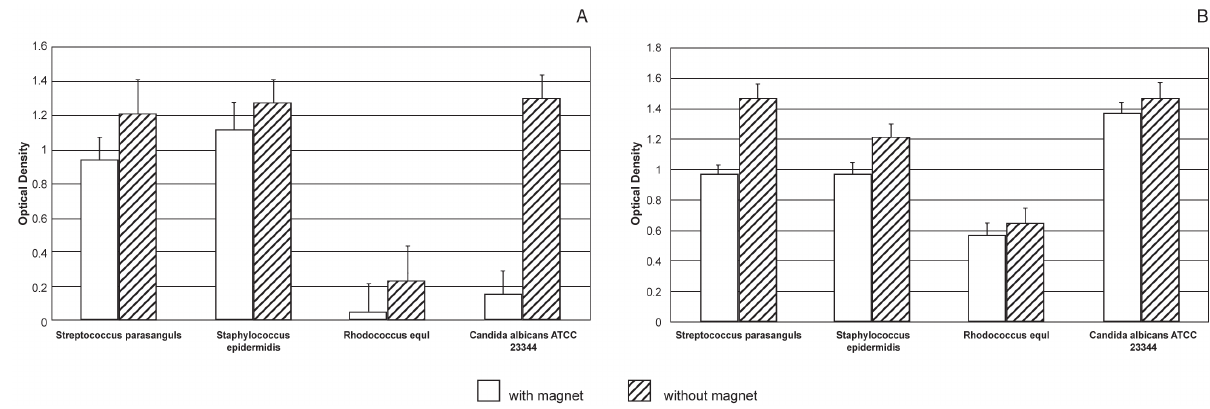
Figure 1- Optical density values upon 24 and 48 h of incubation with a inoculum density of 1 CFU/ml